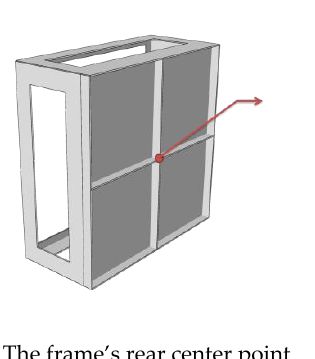
Figure 9. The effect of corrugation shape/topology on the displacement time-history of the frame’s rear center point subjected to 0.5 kg of TNT at R = 0.5 m (BI-5). ( a ) The frame’s rear center point; ( b ) Displacement time-history. Table 5. Comparison between deformations d (in mm) and compressive strains (CS) of the four topologies when subjected to 0.5 kg of TNT at R = 0.5 m (BI-5). Table 5. Comparison between deformations d (in mm) and compressive strains ( CS ) of the four topologies when sub- Table 5. Comparison between deformations d (in mm) and compressive strains ( CS ) of the four topologies when sub- Table 5. Comparison between deformations d (in mm) and compressive strains ( CS ) of the four topologies when sub- Table 5. Comparison between deformations d (in mm) and compressive strains ( CS ) of the four topologies when sub- Table 5. Comparison between deformations d (in mm) and compressive strains ( CS ) of the four topologies when sub- Table 5. Comparison between deformations d (in mm) and compressive strains ( CS ) of the four topologies when sub- Table 5. Comparison between deformations d (in mm) and compressive strains ( CS ) of the four topologies when sub- Table 5. Comparison between deformations d (in mm) and compressive strains ( CS ) of the four topologies when sub- Table 5. Comparison between deformations d (in mm) and compressive strains ( CS ) of the four topologies when sub- Table 5. Comparison between deformations d (in mm) and compressive strains ( CS ) of the four topologies when sub- Table 5. Comparison between deformations d (in mm) and compressive strains ( CS ) of the four topologies when sub- Table 5. Comparison between deformations d (in mm) and compressive strains ( CS ) of the four topologies when sub- jected to 0.5 kg of TNT at R = 0.5 m (BI-5). jected to 0.5 kg of TNT at R = 0.5 m (BI-5). jected to 0.5 kg of TNT at R = 0.5 m (BI-5). jected to 0.5 kg of TNT at R = 0.5 m (BI-5). jected to 0.5 kg of TNT at R = 0.5 m (BI-5). jected to 0.5 kg of TNT at R = 0.5 m (BI-5). jected to 0.5 kg of TNT at R = 0.5 m (BI-5). jected to 0.5 kg of TNT at R = 0.5 m (BI-5). jected to 0.5 kg of TNT at R = 0.5 m (BI-5). jected to 0.5 kg of TNT at R = 0.5 m (BI-5). jected to 0.5 kg of TNT at R = 0.5 m (BI-5). jected to 0.5 kg of TNT at R = 0.5 m (BI-5). Time (ms) Time (ms) 0 Time (ms) Time (ms) Time (ms) 0 Time (ms) Time (ms) Time (ms) Time (ms) 0 Time (ms) Time Time (ms) Table 5. Comparison between deformations d (in mm) and compressive strains ( CS ) of the four topologies when sub- jected to 0.5 kg of TNT at R = 0.5 m (BI-5). Trap.